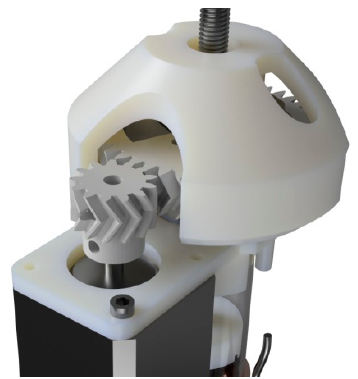
Figure 6. Herringbone gears transmission.